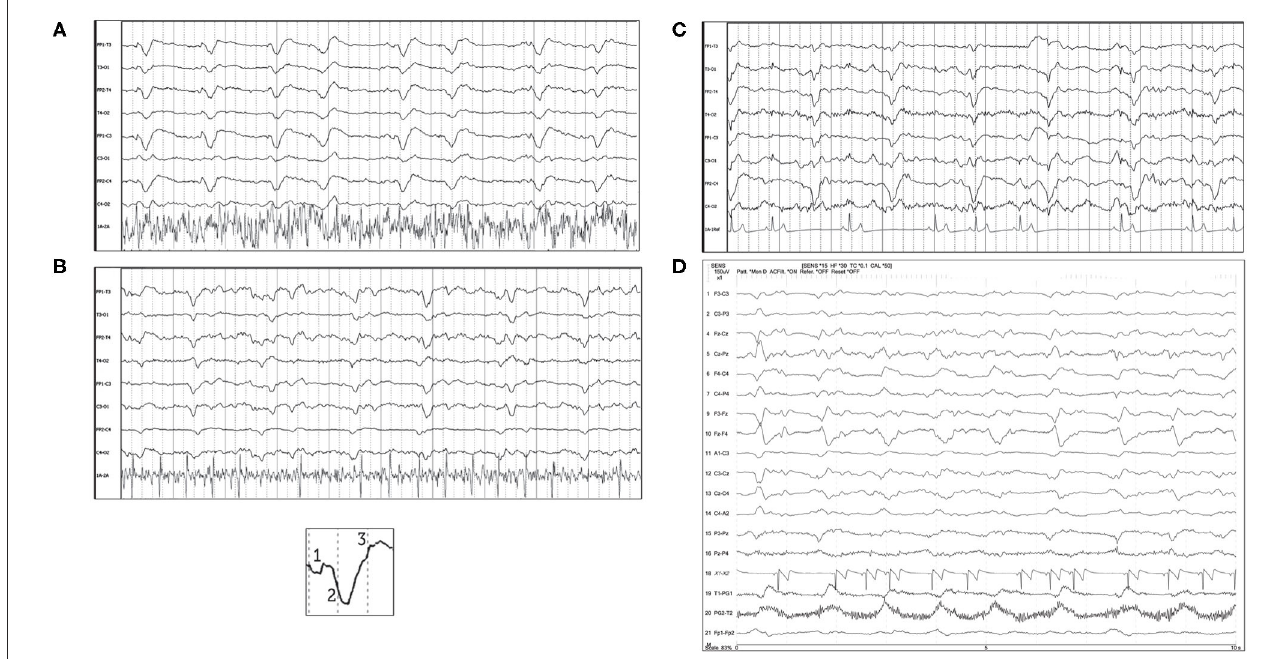
FIGURE8 Bipolar montages of four cases with GPDs with triphasic morphology. The initial phase in each case is very small, with prominent second and third phases (inset figure). (A) Three year old Australian Shepherd mix with seizures and cerebral intra-axial mass on MRI (HF 70Hz, sensitivity 7 uV/mm). (B) Five year old American Staffordshire terrier with cluster seizures, polycythemia (HF 15Hz, sensitivity 3 uV/mm). (C) Five year old Scottish terrier with cluster seizures, likely idiopathic epilepsy (HF 30Hz, sensitivity 15 uV/mm). (D) Four year old wirehair terrier with seizures and HE (HF 30Hz, sensitivity 15